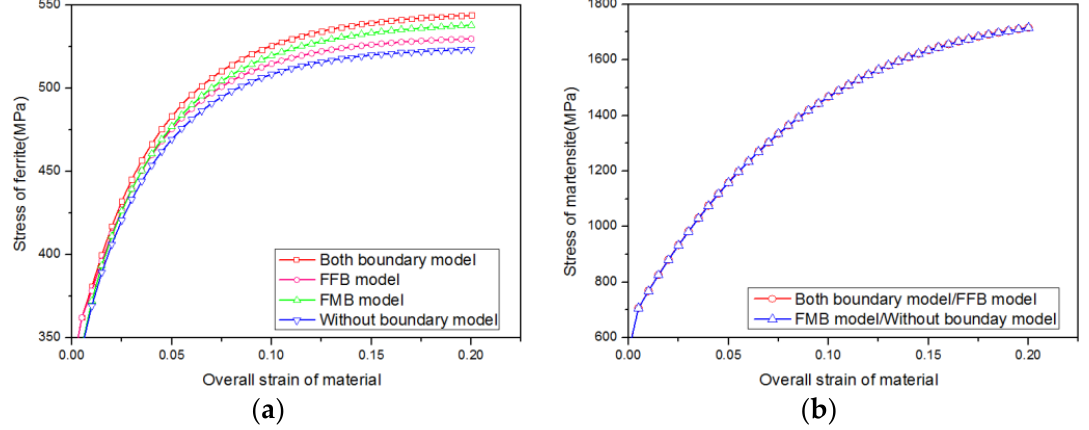
Figure 11. The stress of individual phases: ( a ) ferrite, ( b ) martensite.